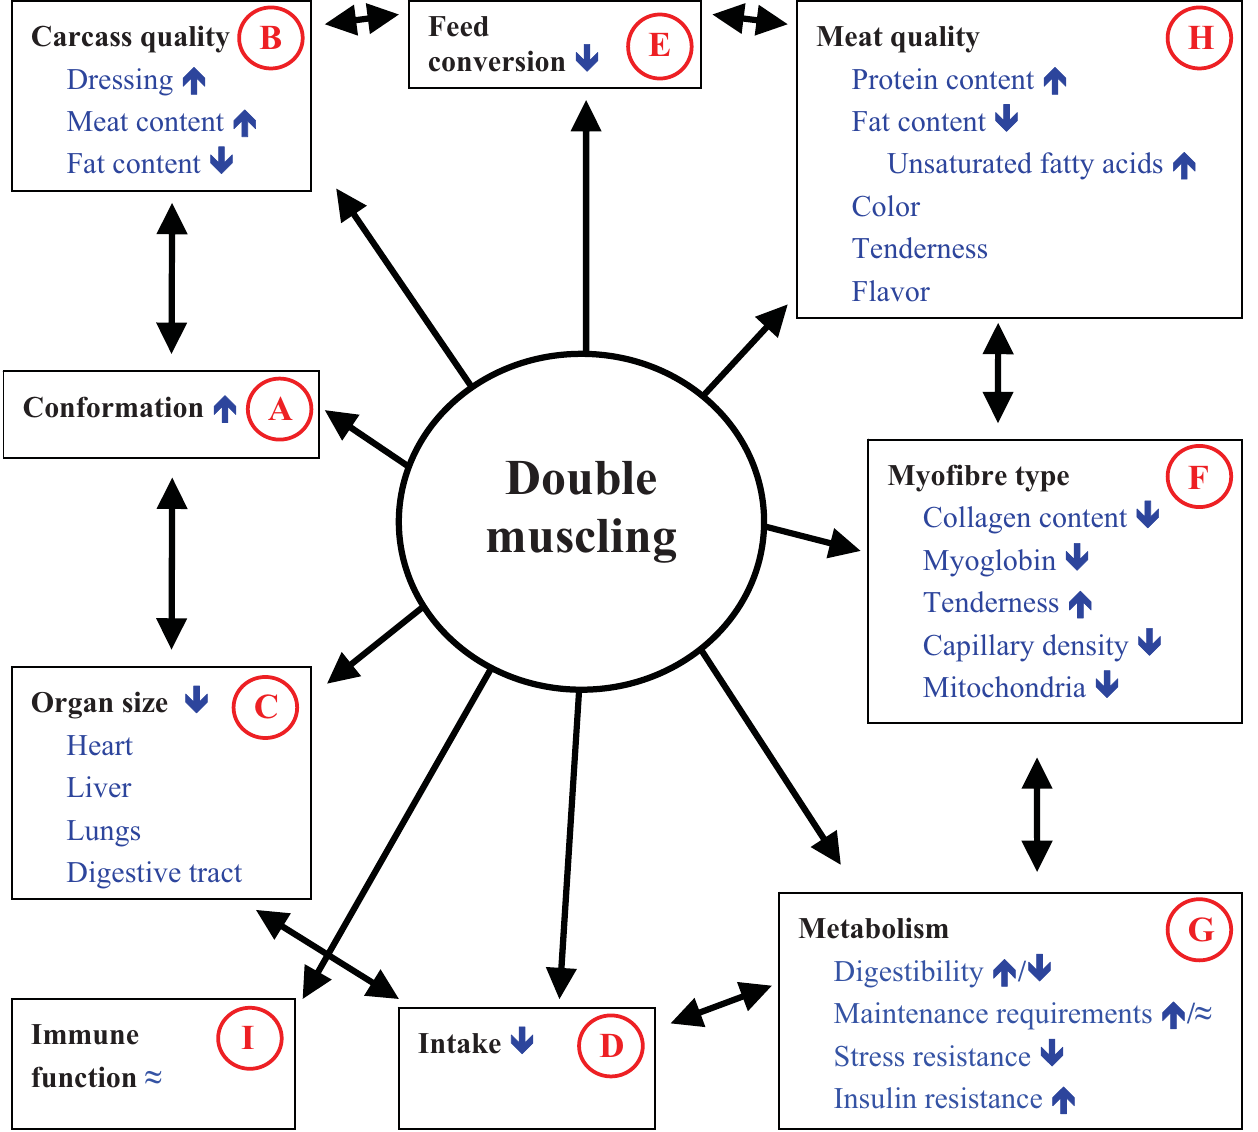
Figure 1. Impact of double muscling on some important animal